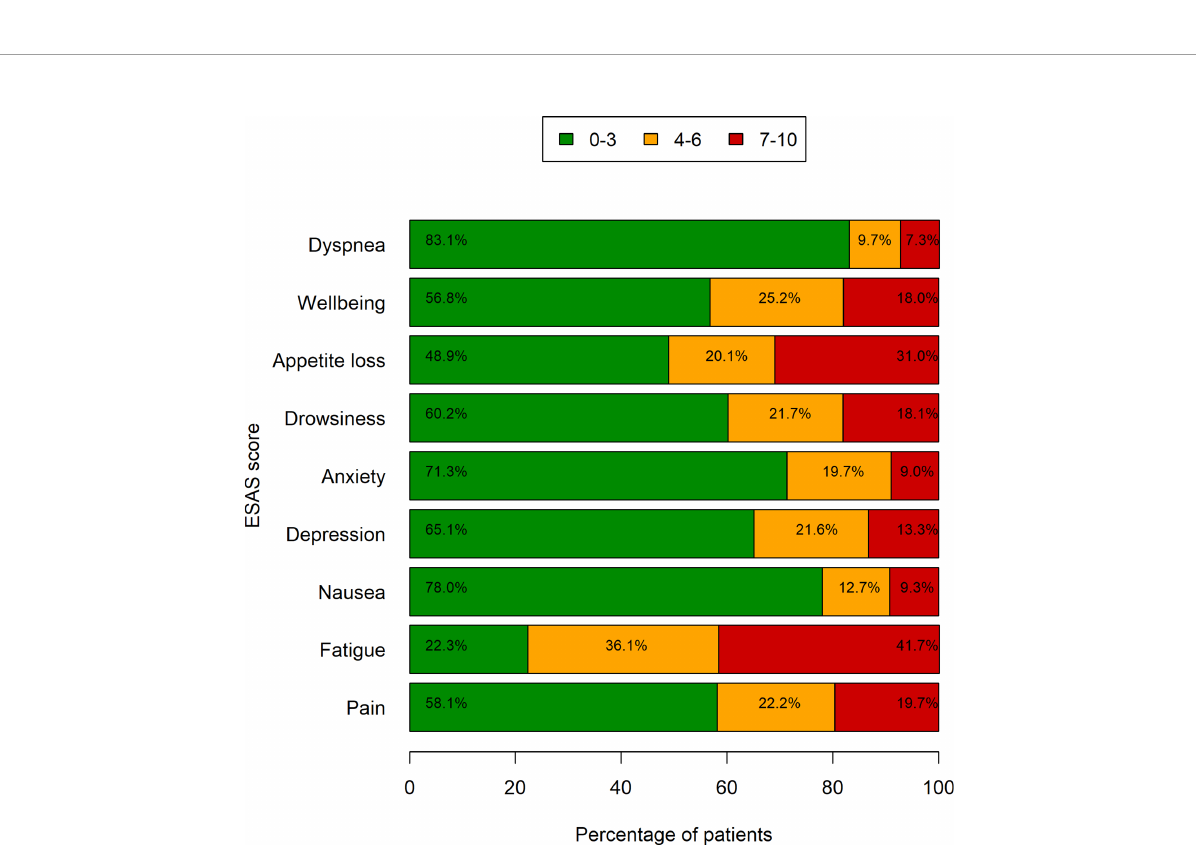
FIGURE 3 Symptom severity by ESAS. Bars represent the frequencies of symptoms grouped by three levels of severity (data missing in up to 92 patients).